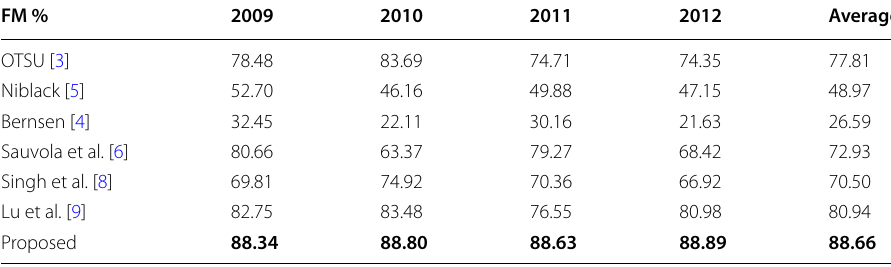
Table 1 Comparison of F-measure for seven methods FM